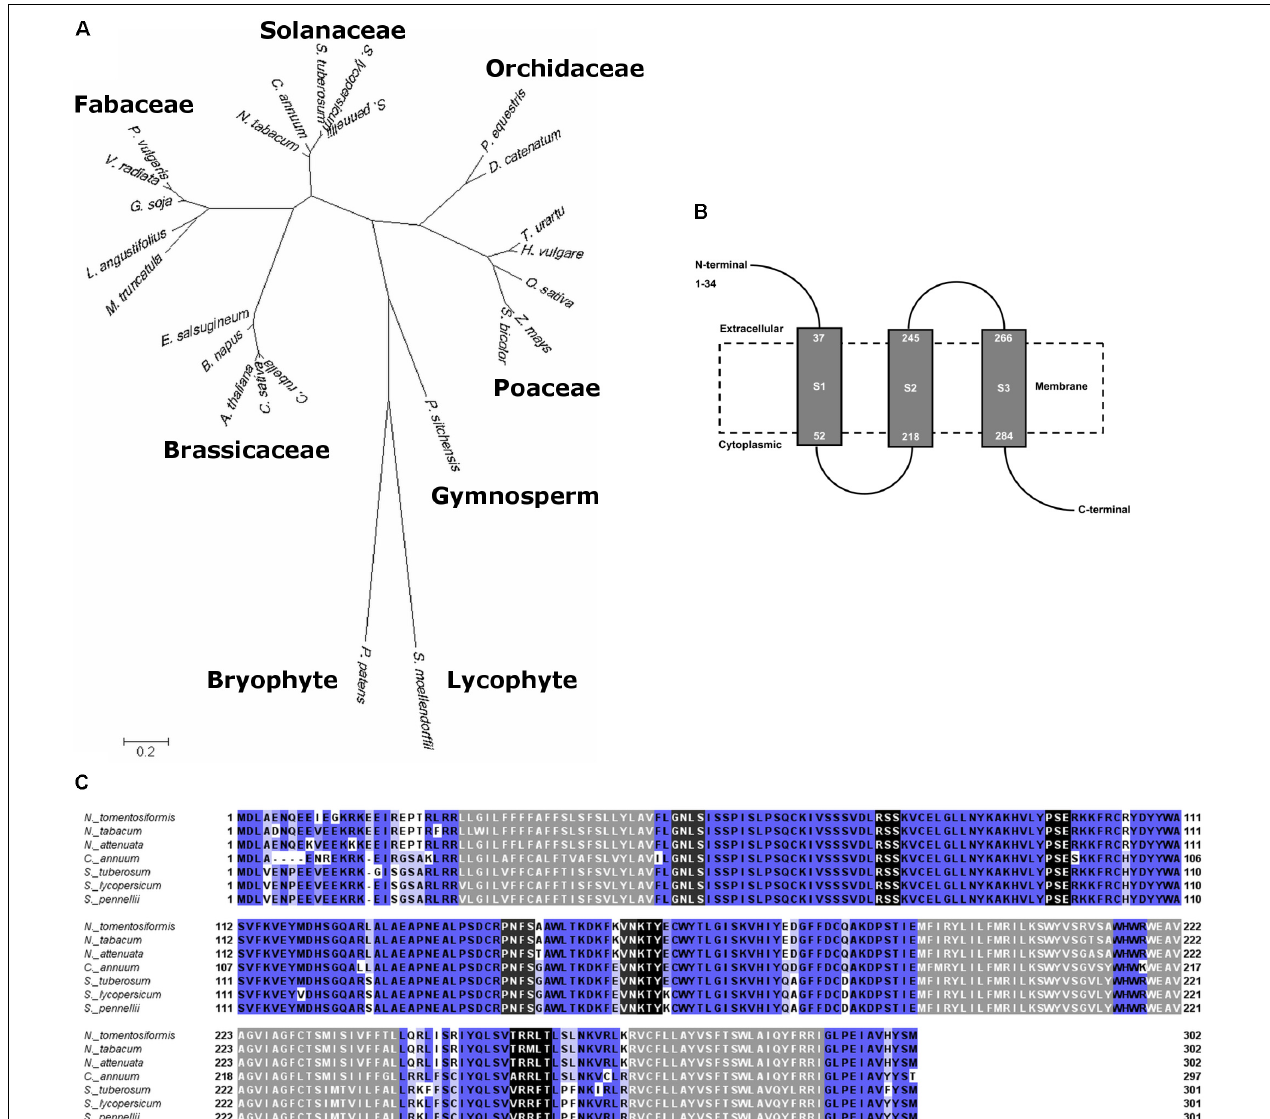
FIGURE 3 | Amino acid sequence analyses of Solyc08g075770. (A) Molecular phylogenetic analysis by Maximum Likelihood method of Solyc08g075770 and similar sequences in different plant species with 500 bootstrap replications. The tree is drawn to scale, with branch lengths measured in the number of substitutions per site. (B) Solyc08g075770 is predicted to be a protein having three transmembrane domains. Gray boxes are the transmembrane domains, and dashed box is an illustrated cell membrane. (C) Multiple alignment of amino acid sequences of Solyc08g075770 and similar sequences in several plants of the Solanaceae family. Sequences that are shaded gray are the predicted transmembrane domains; sequences that are shaded black are phosphorylation sites whereas sequences with dark gray shading are glycosylation sites ( Nicotiana tomentosiformis XM_009622423, N. tabacum XM_016650100, N. attenuata XM_019371074,